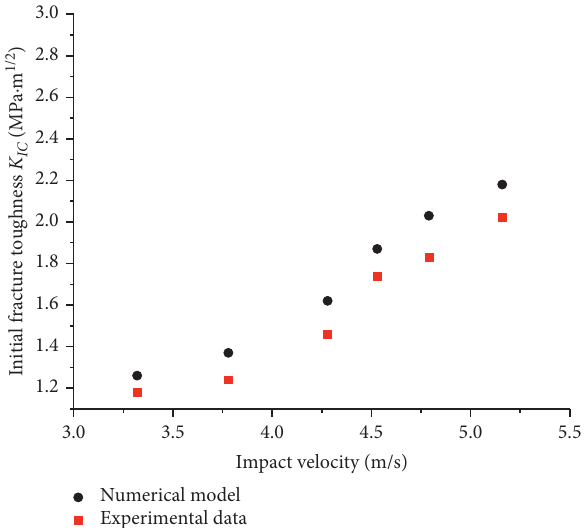
Figure 19: Numerical simulation and experimental results for the initial fracture toughness versus impact velocity.